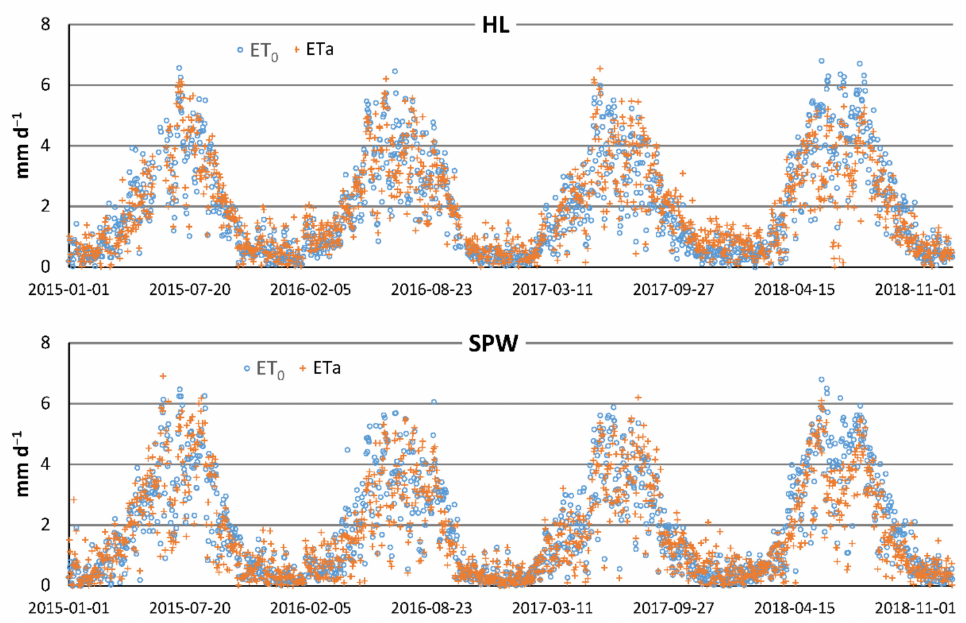
Figure 4. Daily sums of FAO grass reference evapotranspiration ( ET 0 ) and actual evapotranspiration ( ET a ) in Havelländisches Luch (HL) and Spreewald